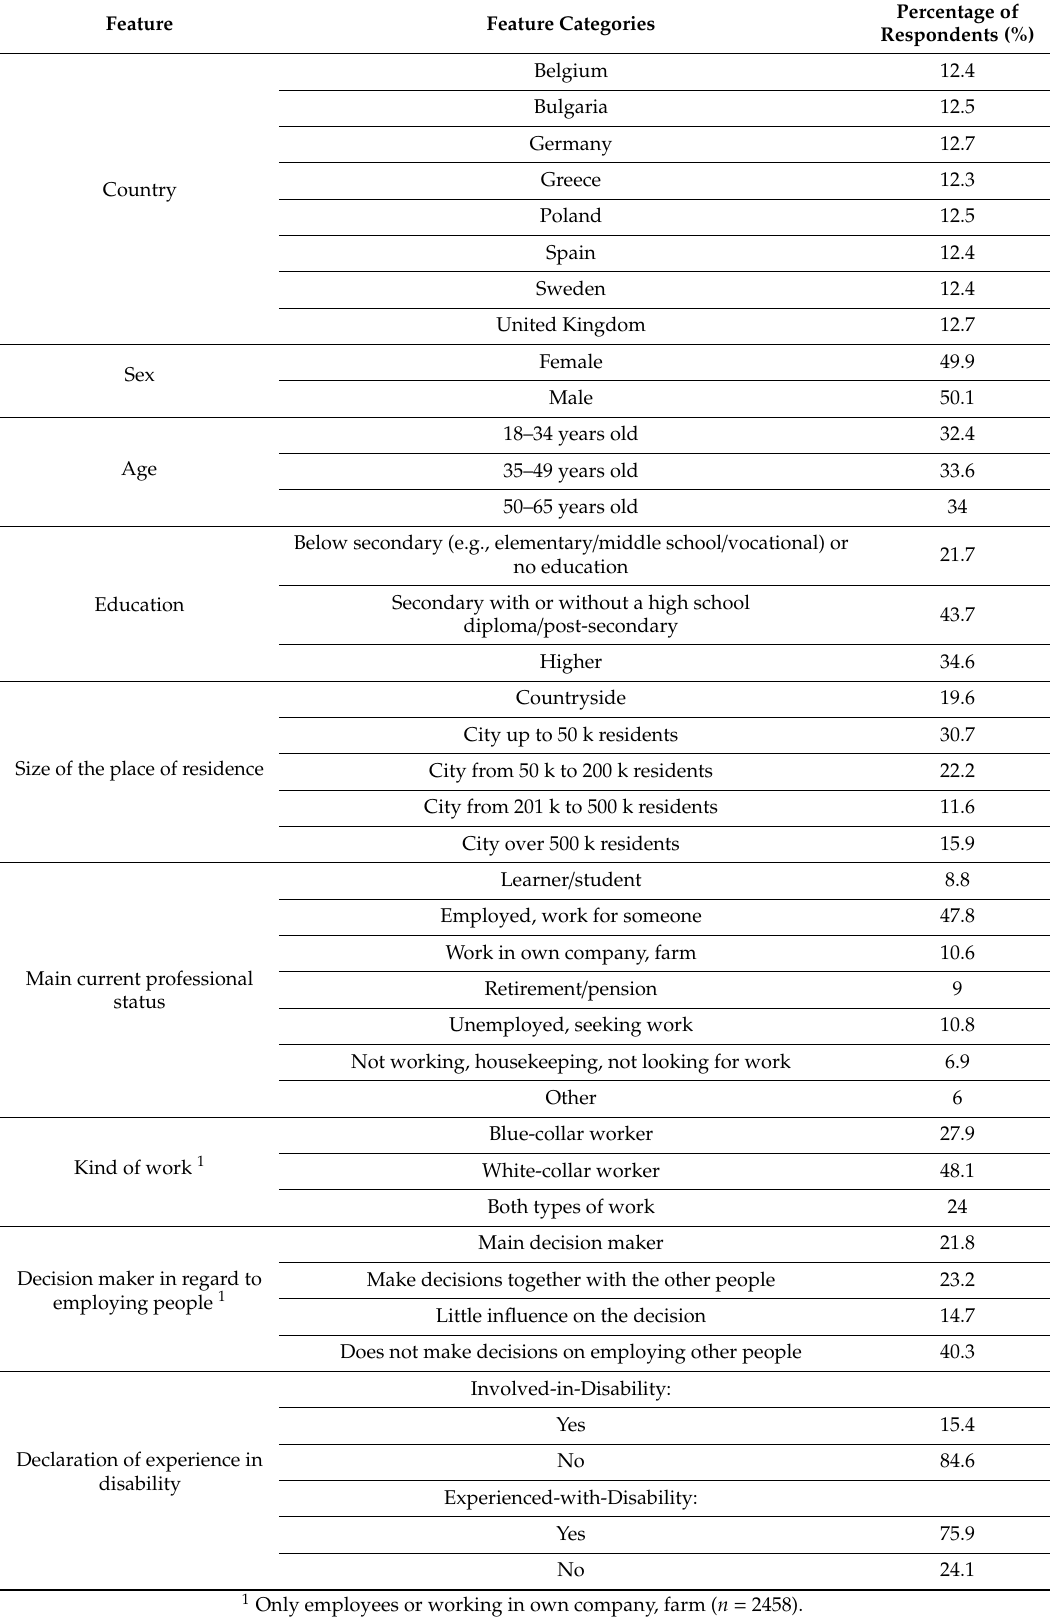
Table 3. Main research sample ( n = 4209)—social, demographic and professional